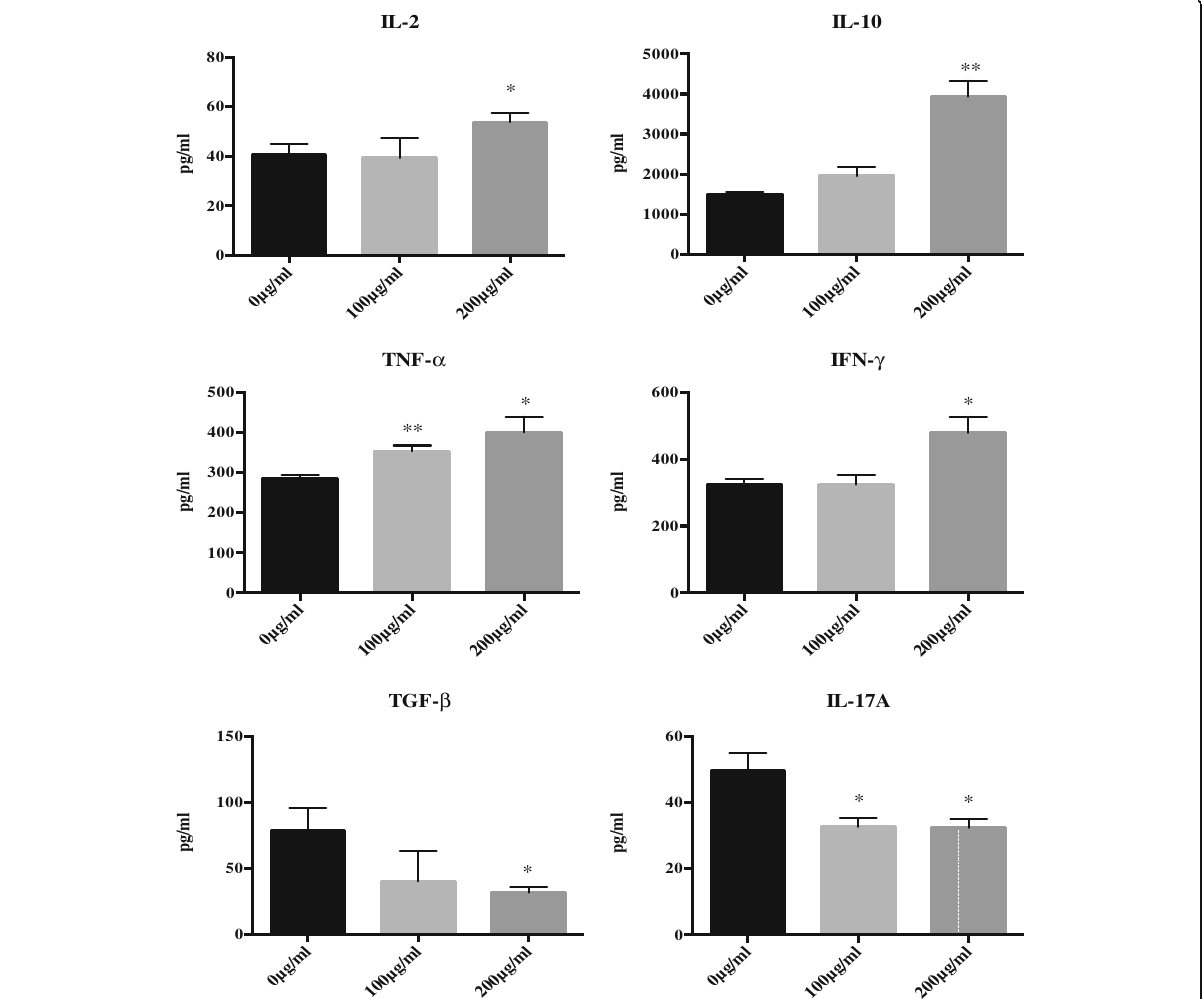
Fig. 3 JC-001 mediates cytokine secretion under co-culture conditions. The effector cell (LLC1 immunized splenocytes) to target cell (LLC1 cells) ratio was 40, and each bar represents the mean ± standard deviation ( n = 3). * p < 0.05, ** p < 0.01 compared with the control group. After co-culture for 48 h, JC-001 up-regulated IL-2, IL-10, TNF- α and IFN- γ and down-regulated IL-17A, and TGF- β in the condition medium. The results are expressed as mean ± SD of three separate